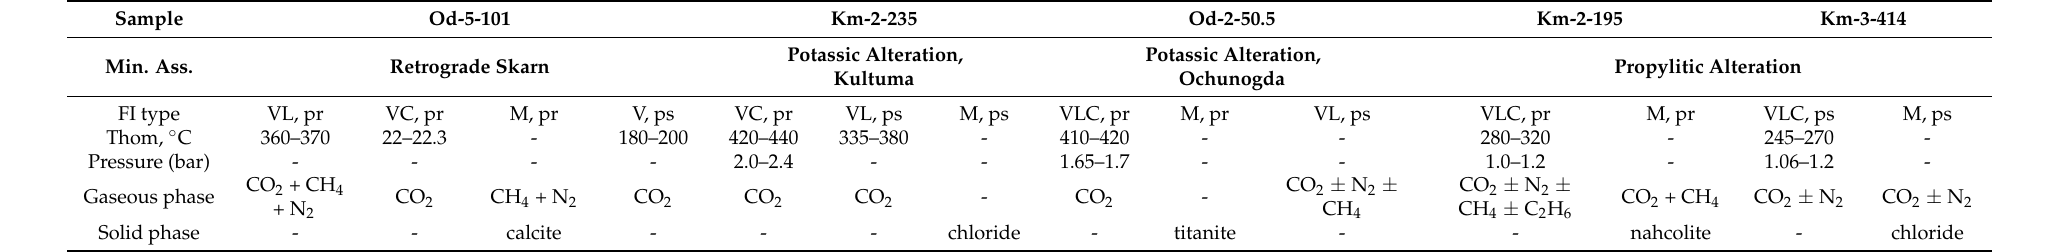
Table 3. Summary microthermometric and Raman spectroscopy data of fluid inclusions from quartz of the Kultuma